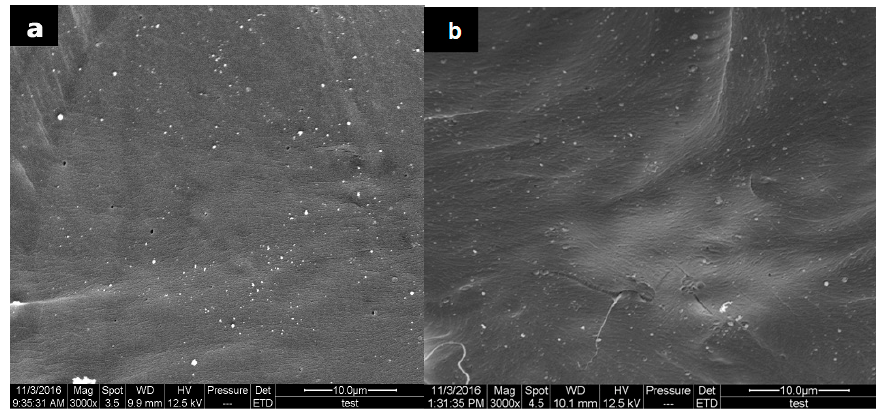
Figure 10. Scanning electron microscope (SEM) cross-sections of PLA/ACNC composite films: ( a ) PLA-0.5-20-ACNC, ( b ) PLA-0.5-40-ACNC.